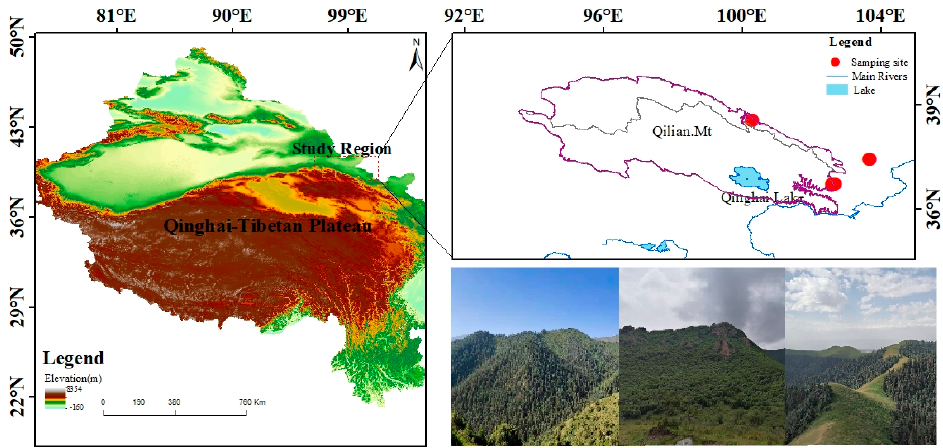
Figure 1. Locations of the sampling sites.